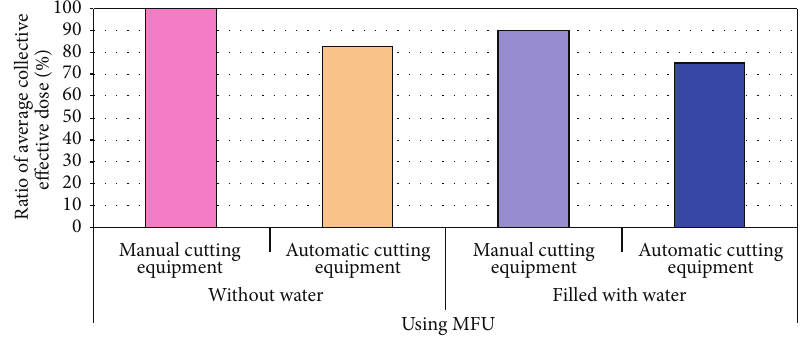
Figure 7: The comparison of the collective effective doses if MFU is used during dismantling of the ECCS